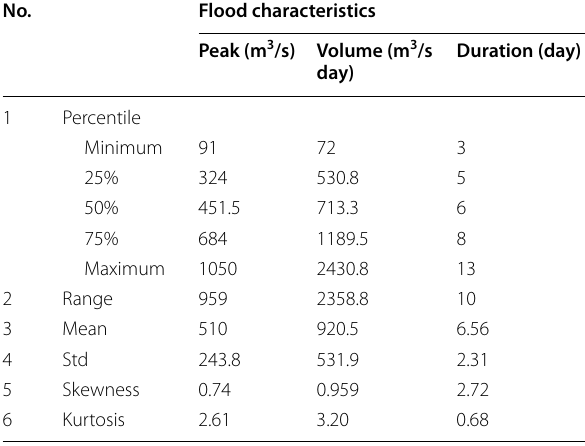
Table 1 Statistical characteristics of flood variables No. Flood